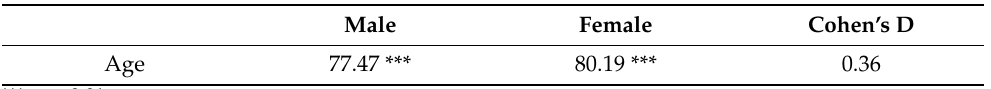
Table 5. Age of persons over 65 years old living alone based on sex. Basic Health Areas of Gran Canaria. 2018–2020. Medians. Male Female Cohen’s D